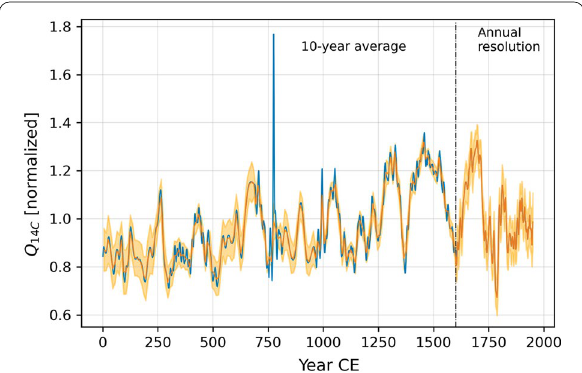
Fig. 2 14 C production rate for the last 2000 years inferred from IntCal20. The blue line indicates the mean of a hundred realizations of annual 14 C production rate inferred from IntCal20 and normalized to have the pre-industrial mean of one. The SPEs during 774–775 CE and 993–994 CE can be observed as rapid rises in the 14 C production rate. The orange line and orange shading indicate the mean and 2-sigma uncertainty of 100 realizations of the processed 14 C data (see